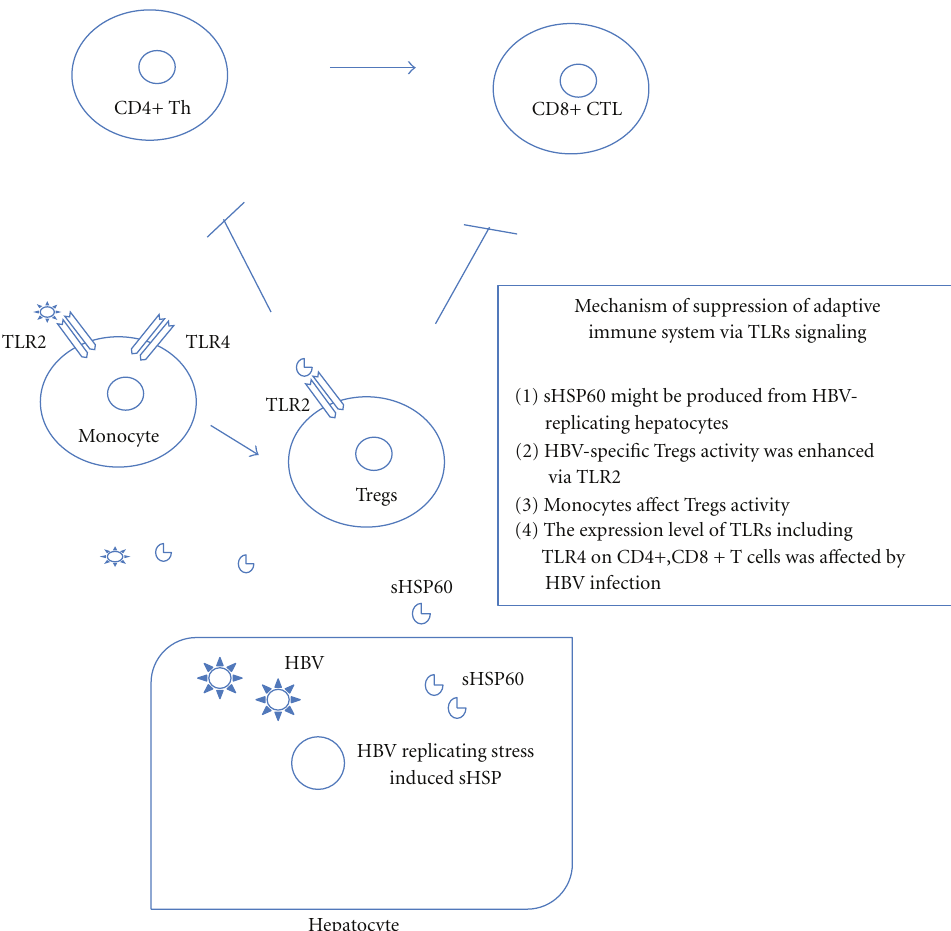
Figure 2: TLRs contribution to PBMC, CD3+/CD4+/CD8+ T cells, and Tregs-related immune